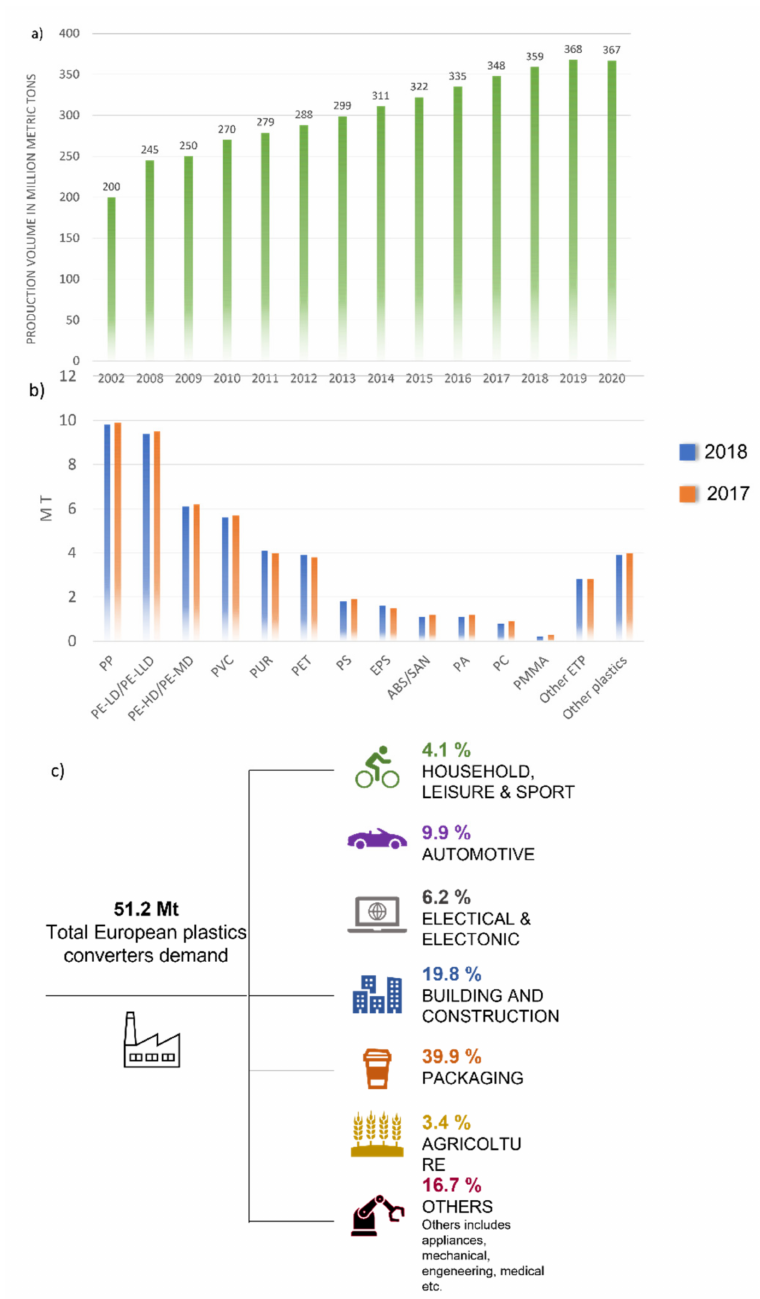
Figure 1. ( a ) World polymer production in metric tons; ( b ) distribution of main polymers produced; ( c ) 2018 European plastic converter demand and